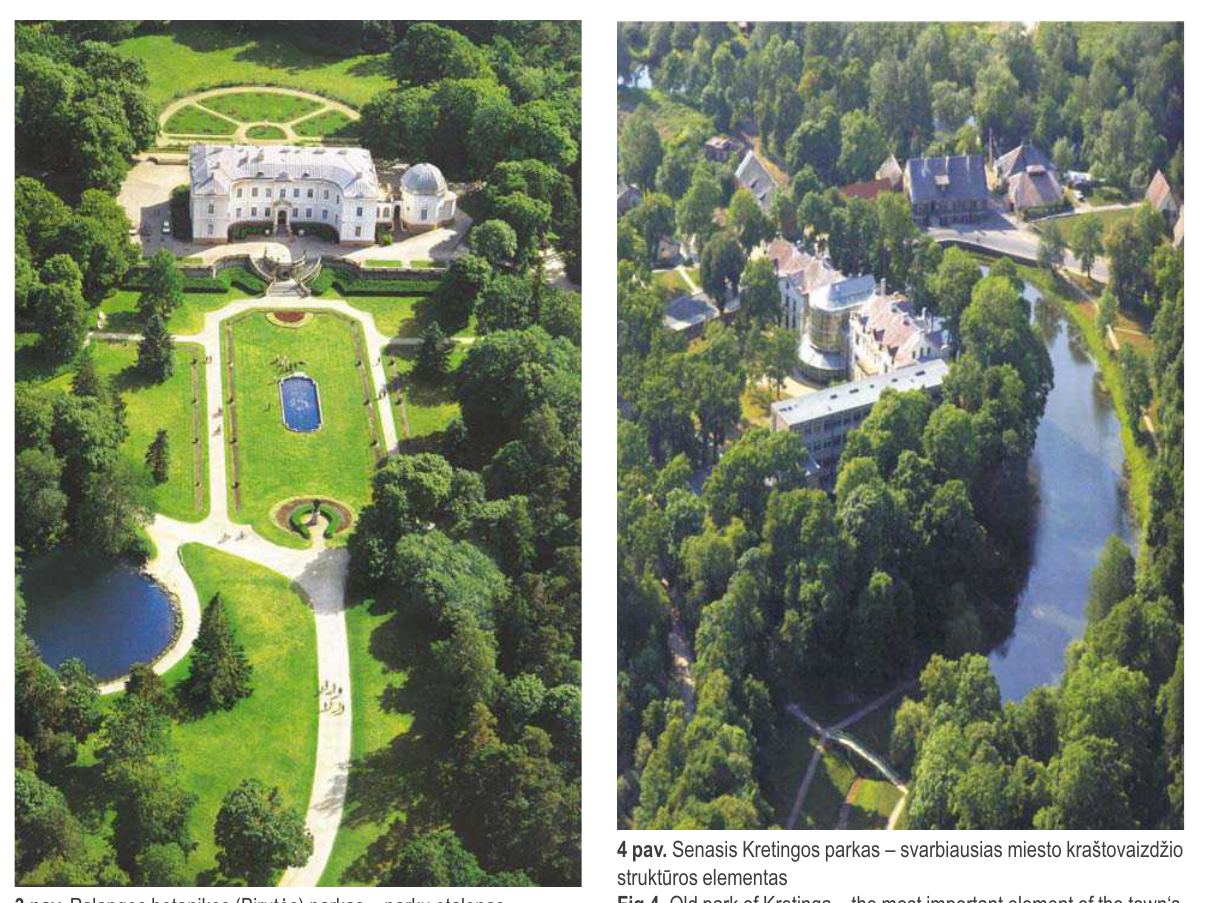
Fig 3. Palanga Botanical (Birutė) Park as park standard